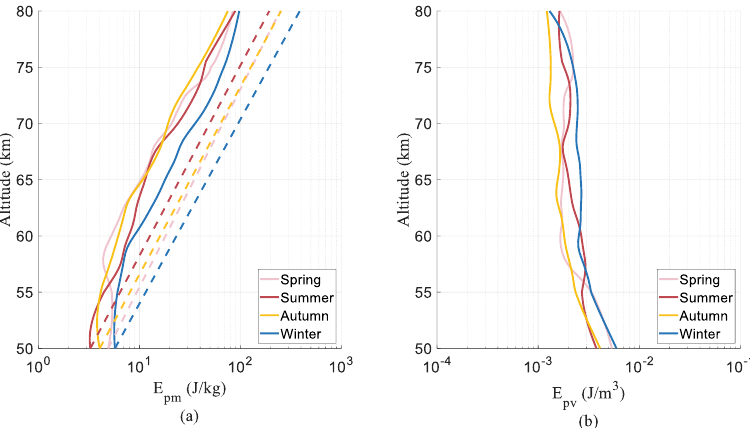
Figure 5. Seasonal average profiles of GWPED. ( a ) The solid lines are the E pm profiles, and the dotted lines are the E pm profiles of the conservative AGWs. ( b ) The E pv profiles.